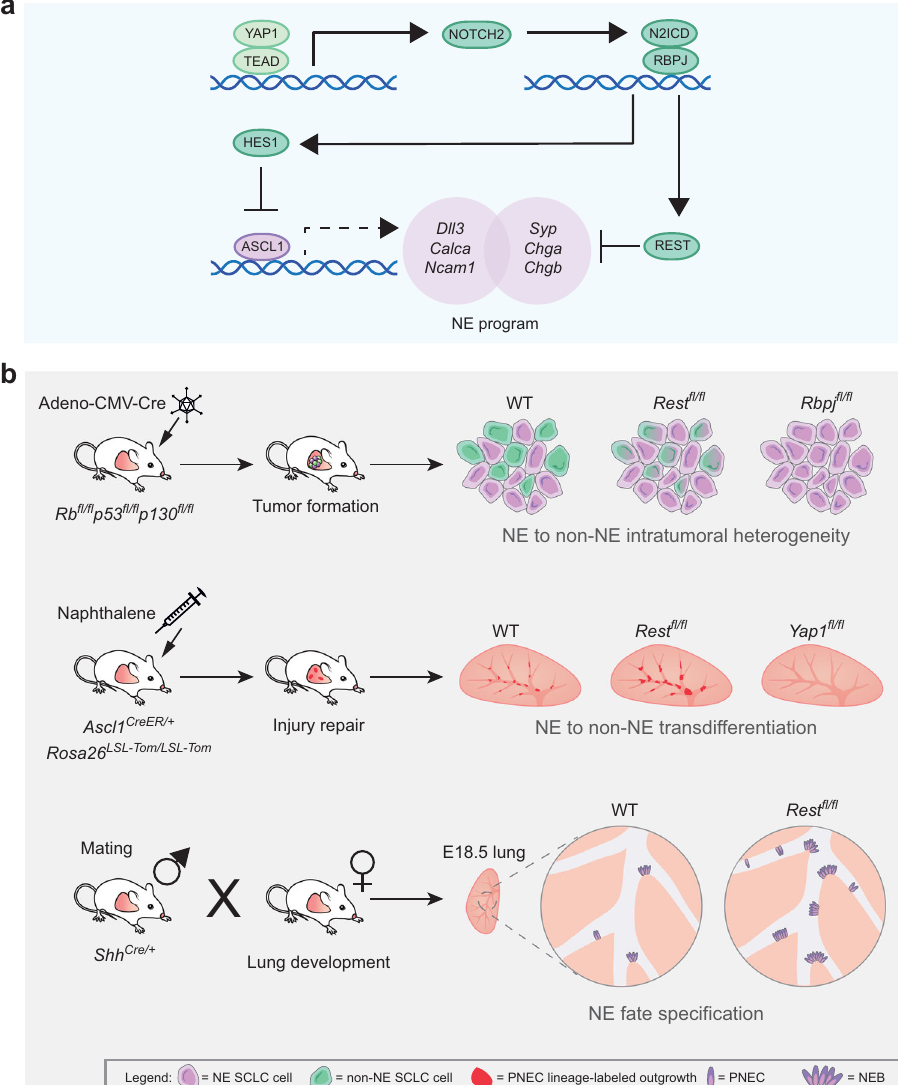
Fig. 8 A conserved YAP/Notch/REST network controls the neuroendocrine cell fate in the lungs. a Schematics of the molecular pathway governing the activation/repression of the neuroendocrine programs. Active YAP1 upregulates the expression of NOTCH2, which in turn increases the expression of REST and HES1. HES1 represses the transcription of Ascl1 , indirectly repressing the genes under ASCL1 transcriptional control, while REST directly represses the transcription of a distinct part of the neuroendocrine program. b Schematics of the in vivo experiments testing the effect of the loss of Rest/Rbpj/Yap1 on intratumoral heterogeneity, transdifferentiation during injury repair, and neuroendocrine fate speci fi cation during lung development. In the tumor model, loss of Rest prevents full transition to the non-neuroendocrine fate in contrast to Rbpj , which completely blocks the transition. In the injury model, Rest deletion delays terminal transdifferentiation resulting in a longer proliferation phase and larger outgrowths. Yap1 deletion blocks the ability of PNECs to respond to the injury, leading to the reduction in outgrowths/transdifferentiation. In the development model, the absence of REST promotes the neuroendocrine fate, causing an increase in the number of pulmonary neuroendocrine cells (PNECs) and neuroepithelial bodies (NEBs) in the